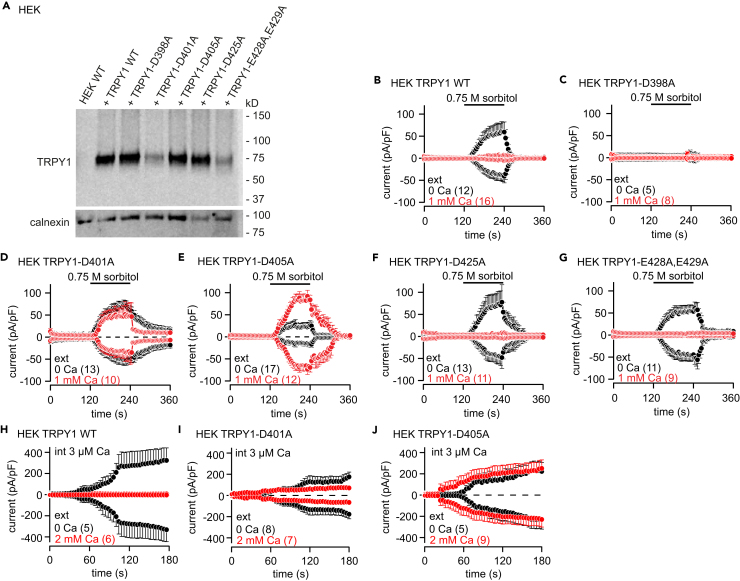
Wild-Type and Mutant TRPY1 Currents Recorded from HEK-293 Cells(A) Western blot of protein lysates from non-transfected HEK-293 cells (HEK WT) and HEK-293 cells transfected with the YVC1 wild-type (+ TRPY1 WT) and the mutant YVC1 cDNAs as indicated. The filter was stripped and incubated with an antibody for calnexin as loading control (bottom panel).(B–J) Inward and outward currents at −80 and 80 mV extracted from 400-ms ramps (0.5 Hz) spanning from −100 to 100 mV, Vh = 0 mV, plotted versus time, activated by 0.75 M sorbitol (bar, hyperosmotic shock; B–G) or 3 μM cytosolic Ca2+ (H–J) at 0 (black), 1 (B–G), or 2 mM (H–J) external Ca2+ (red) in HEK-293 cells transiently transfected with WT (B and H) or mutant (C–G, I, and J) YVC1 cDNAs. Currents are normalized to the cell size (pA/pF). Data are shown as means ± SEM with the number of measured cells in brackets.See also Figure S5.